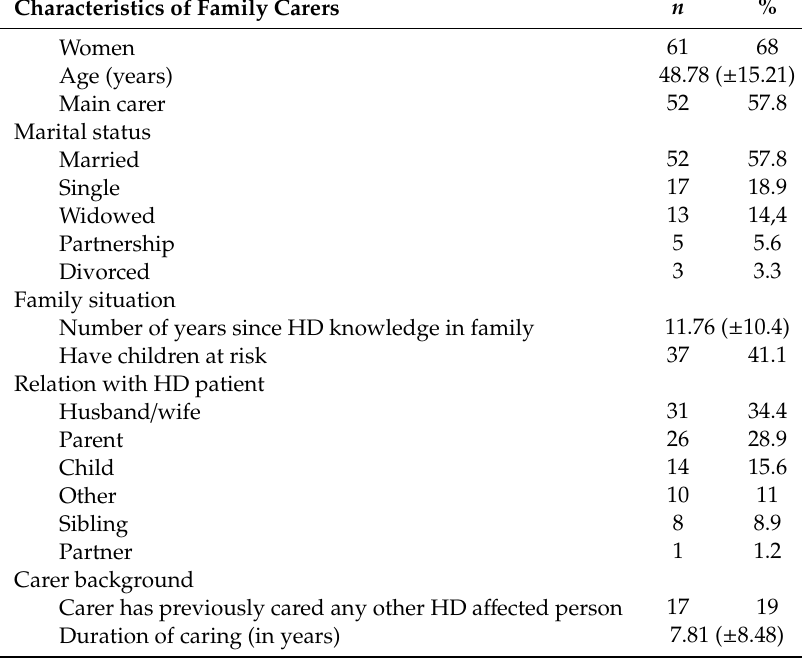
Table 1. Characteristic of the researched group family carers ( n =